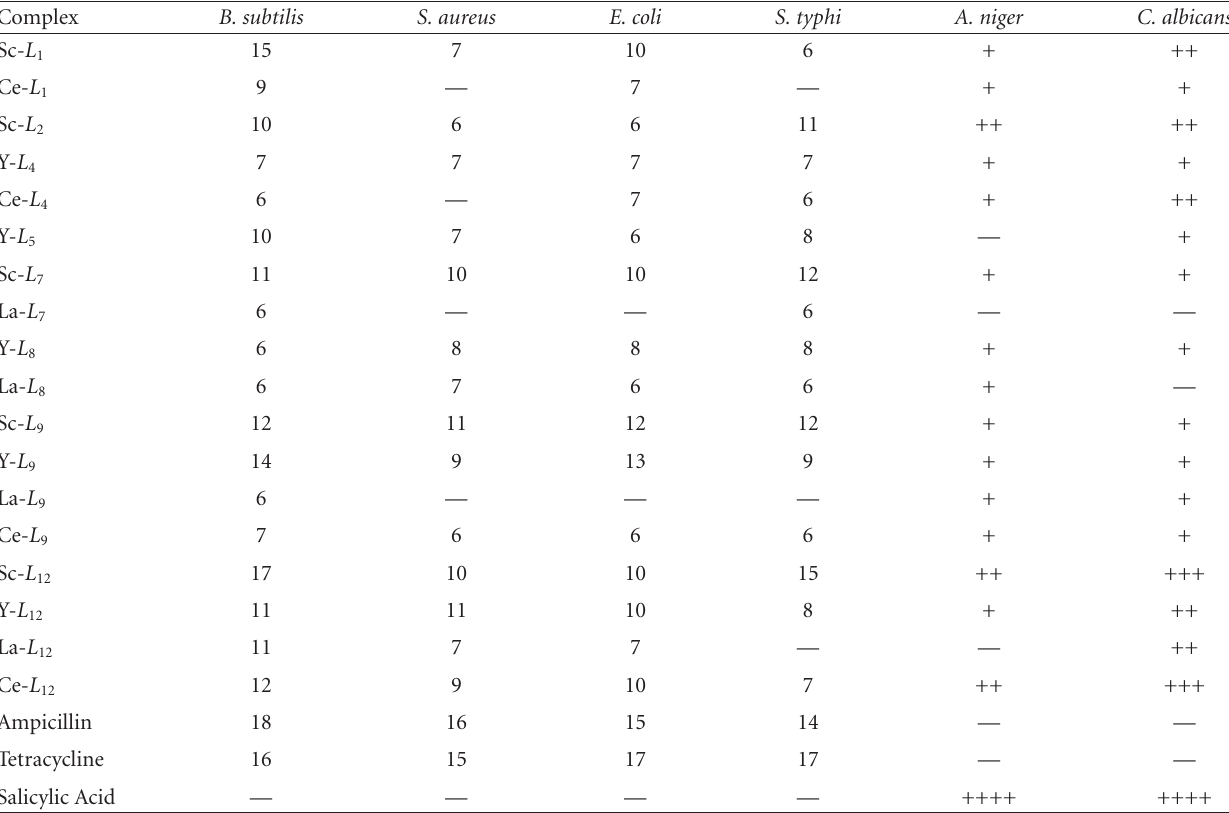
Table 8: Antimicrobial activity data for the complexes ∗